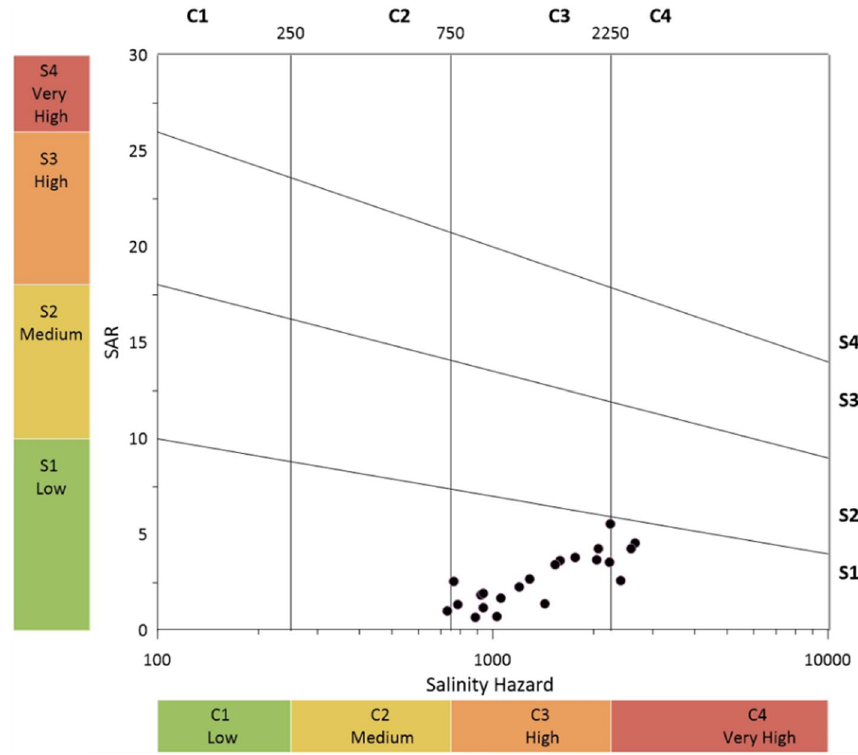
Fig. 10 Groundwater quality